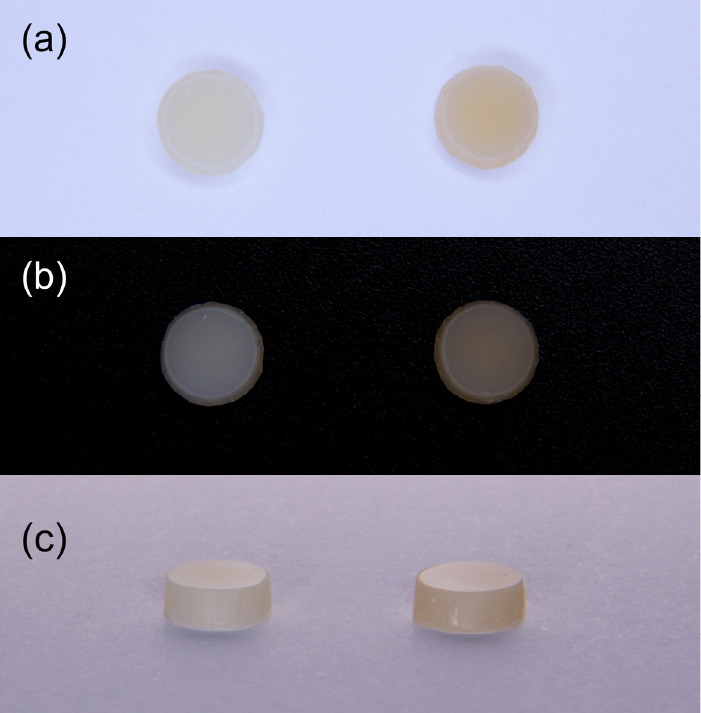
Figure 1. The light (left) and dark (right) composite specimens against the white (a) and black (b) backgrounds and their lateral view (c).